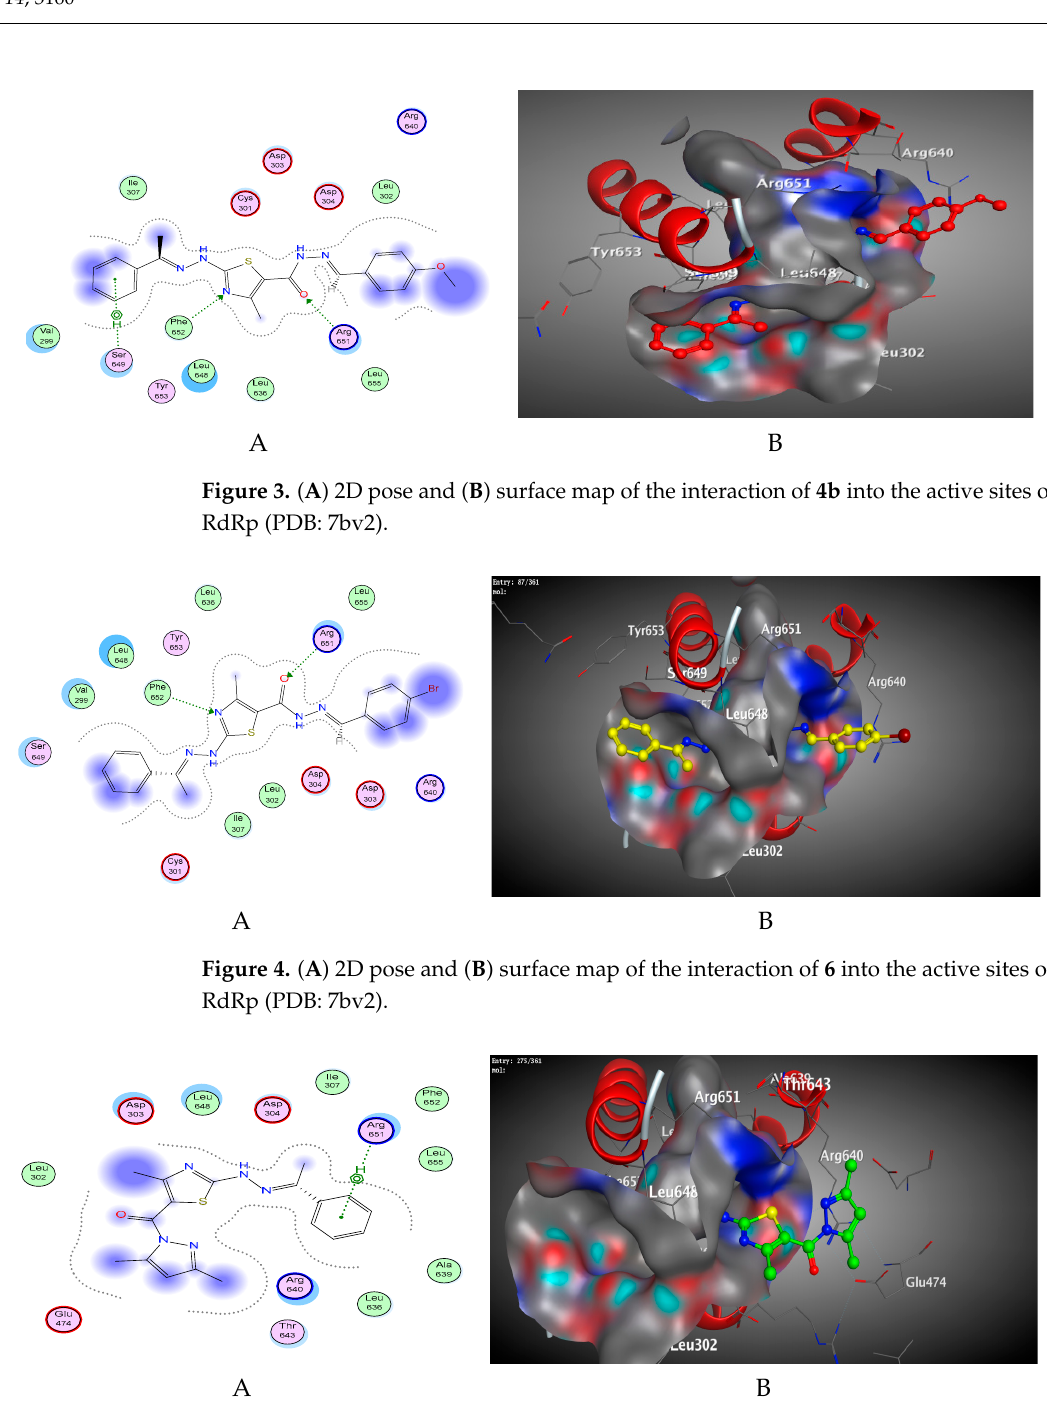
Figure 5. ( A ) 2D pose and ( B ) surface map of the interaction of 16 into the active sites of SARS-CoV- 2 RdRp (PDB: 7bv2). RdRp (PDB: